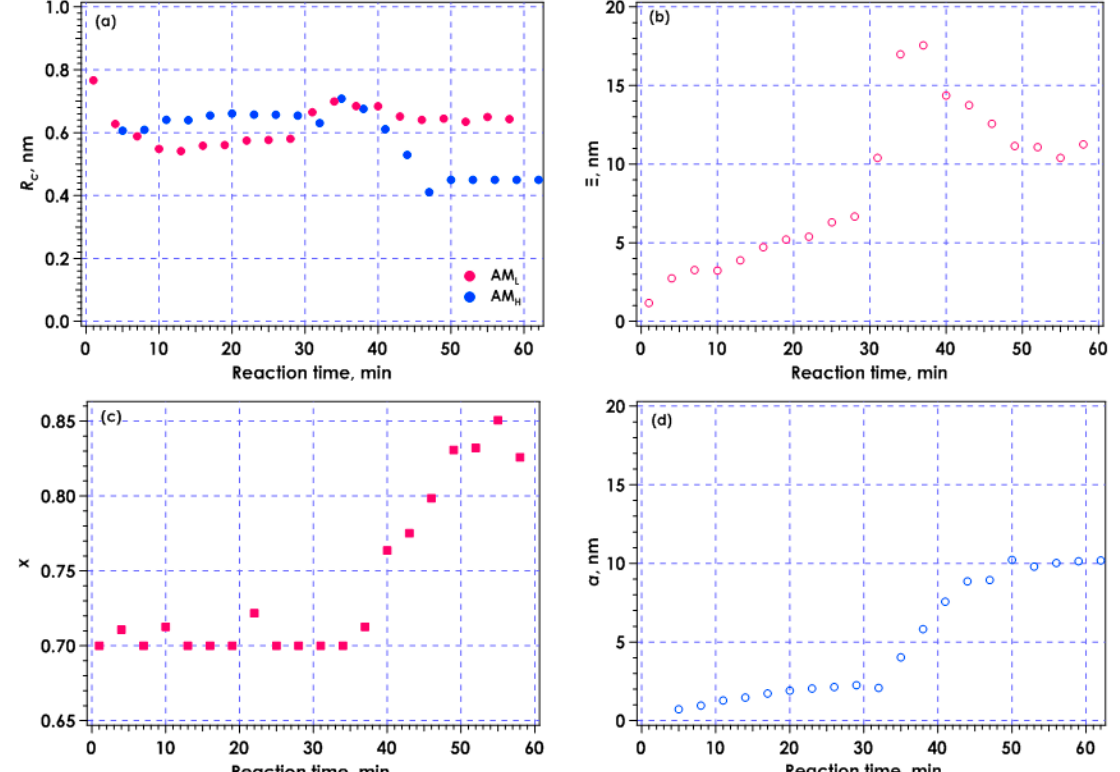
Figure 8. Time course for parameters evaluated from fitting with scattering functions. ( a ) Cross-sectional radius of rod, R c , for AM L and AM H system; ( b ) Correlation length Ξ for AM L ; ( c ) Exponent, x , for AM L ; ( d ) Measure of inhomogeneity, a , for AM H.